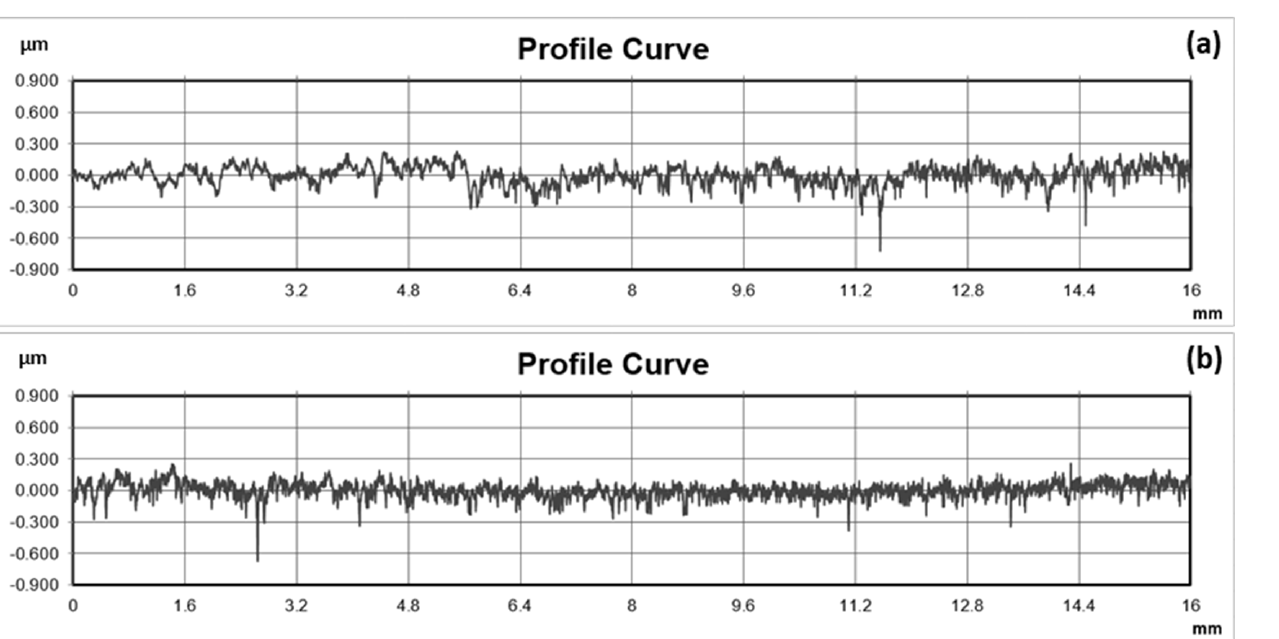
Figure 5. Roughness profile curves measured on steel sample contact surfaces: ( a ) surface A; ( b ) surface B.